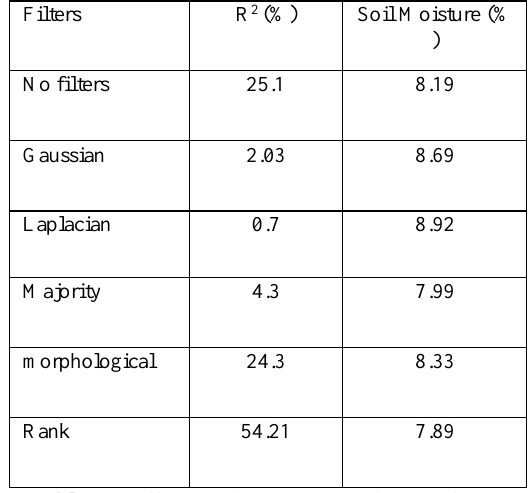
Table 2. coefficient of determination for each filters in Sentinel-1.